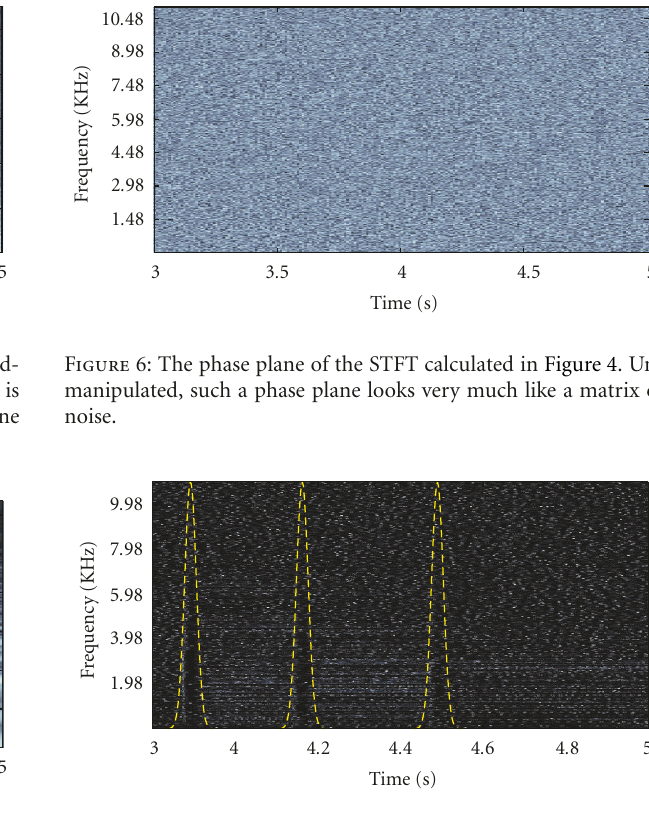
Figure 5: The magnitude plane of the constant- Q transform of the same piece as in Figure 4. The sampling frequency is 22050 Hz, the window width is 30milliseconds, and the number of bins per octave is 48. The dashed line reveals the labeled onset positions.